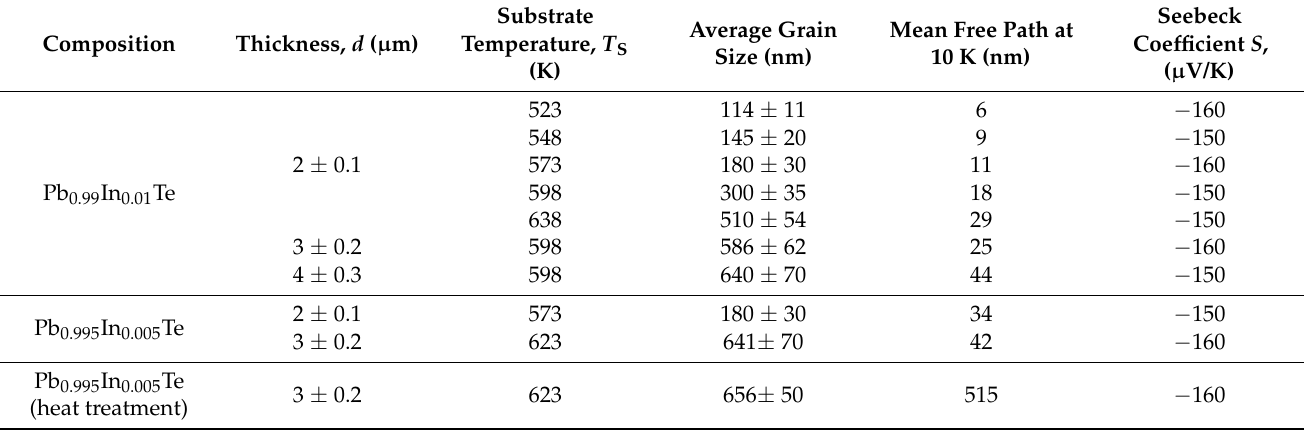
Table 1. The main parameters of PbTe:In films on polyimide